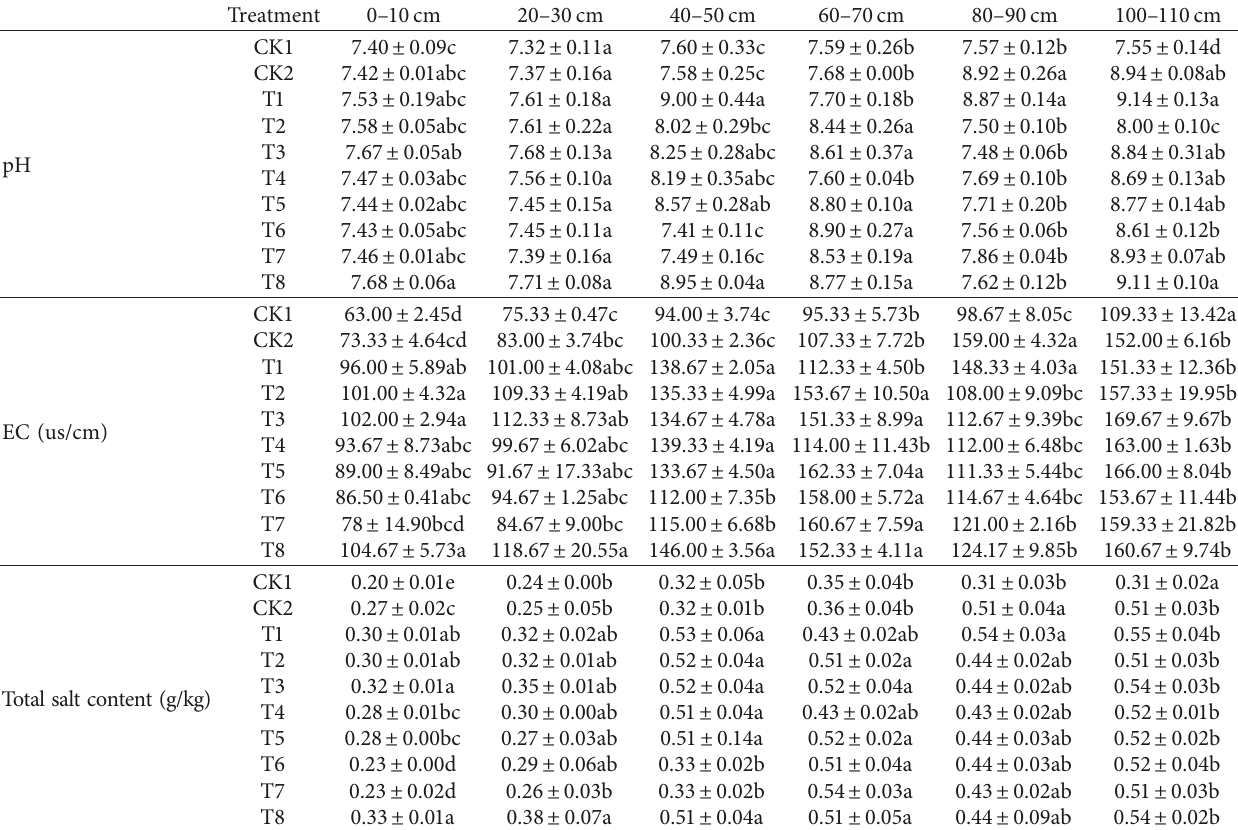
Table 3: Acidity alkalinity, electrical conductivity (Eh), and total soil salt content. Treatment